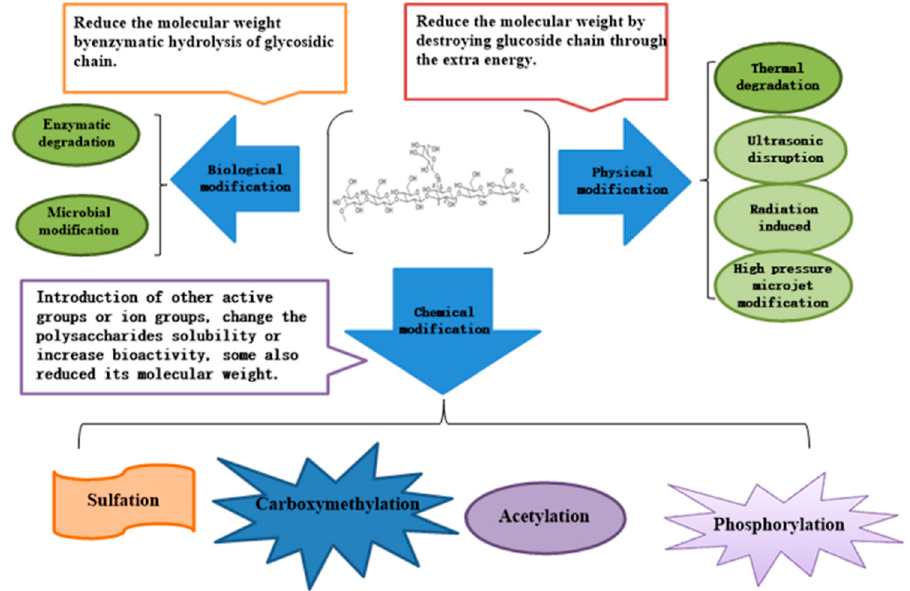
Figure 4. Major methods of molecular modification of β -glucan.